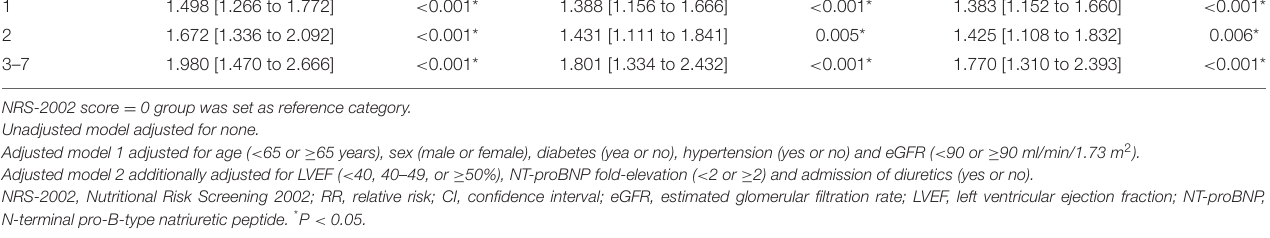
TABLE 2 | Log-binomial regression analysis of NRS-2002 categories with 1-year re-hospitalization. NRS-2002 Unadjusted model Adjusted model 1 Adjusted model 2 RR [95% CI] P -value RR [95%